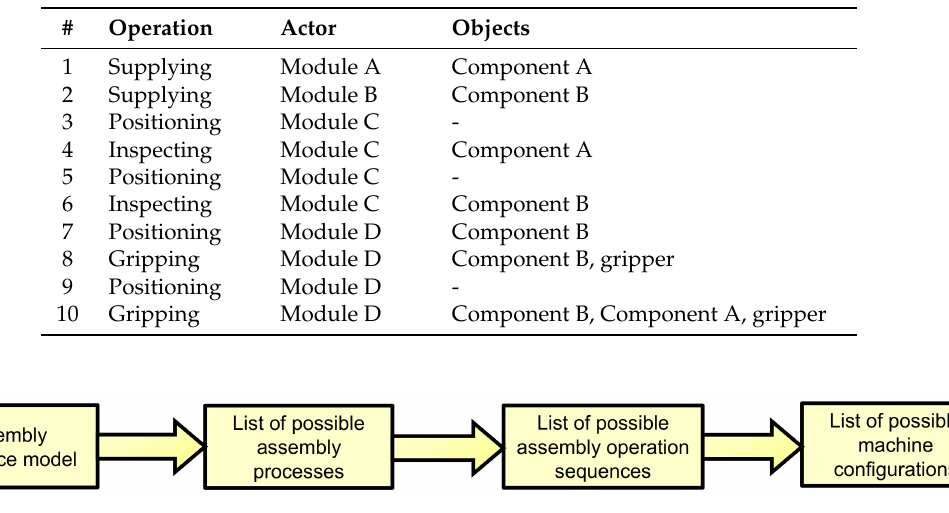
Figure 4. The four stages in generating an automated feedback for the designer: The assembly sequence model is being transformed into a list of possible assembly processes by stochastic combination. Next, a list of possible assembly operation sequences is created by using known operation sequences of procedure types. Finally, the feature based description of the RMS is used to generate the list of possible machine